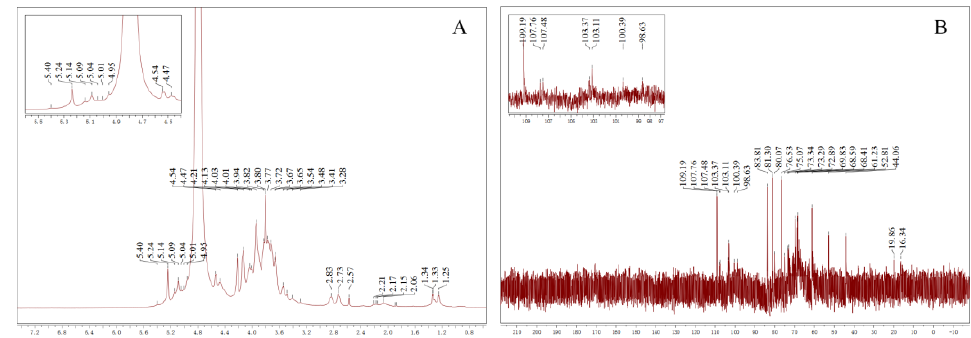
Figure 3. NMR spectra of LPP. ( A ) 1 H NMR spectrum and ( B ) 13 C NMR